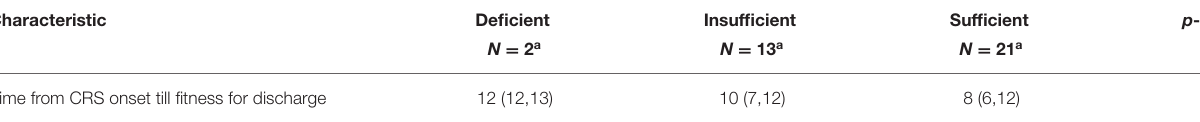
TABLE 7 | The association between serum 25(OH)D levels and median time from CRS till discharge. Characteristic Deficient Insufficient